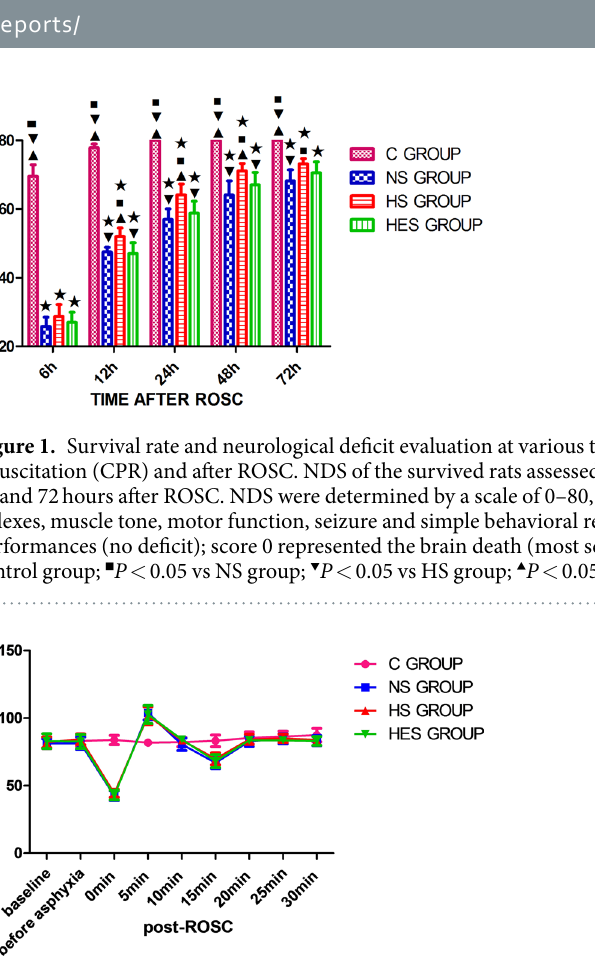
Figure 2. Changes of mean arterial pressure (MAP) in C, NS, HS and HES groups during cardiopulmonary resuscitation (CPR) and after ROSC. MAP of different groups at baseline, before asphyxia, and different time points after ROSC. 0 min after ROSC means the time that return of spontaneous sinus rhythm. All the MAP were measured by Powerlab 16/30 from femoral